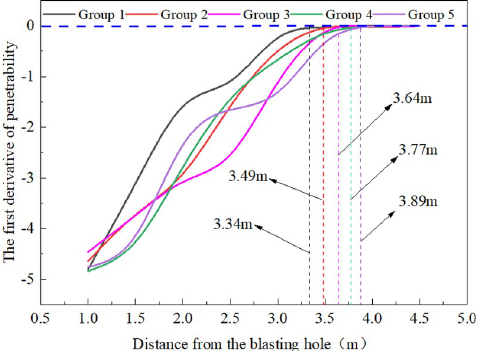
Fig 14. First derivative curve of the permeability of the coal